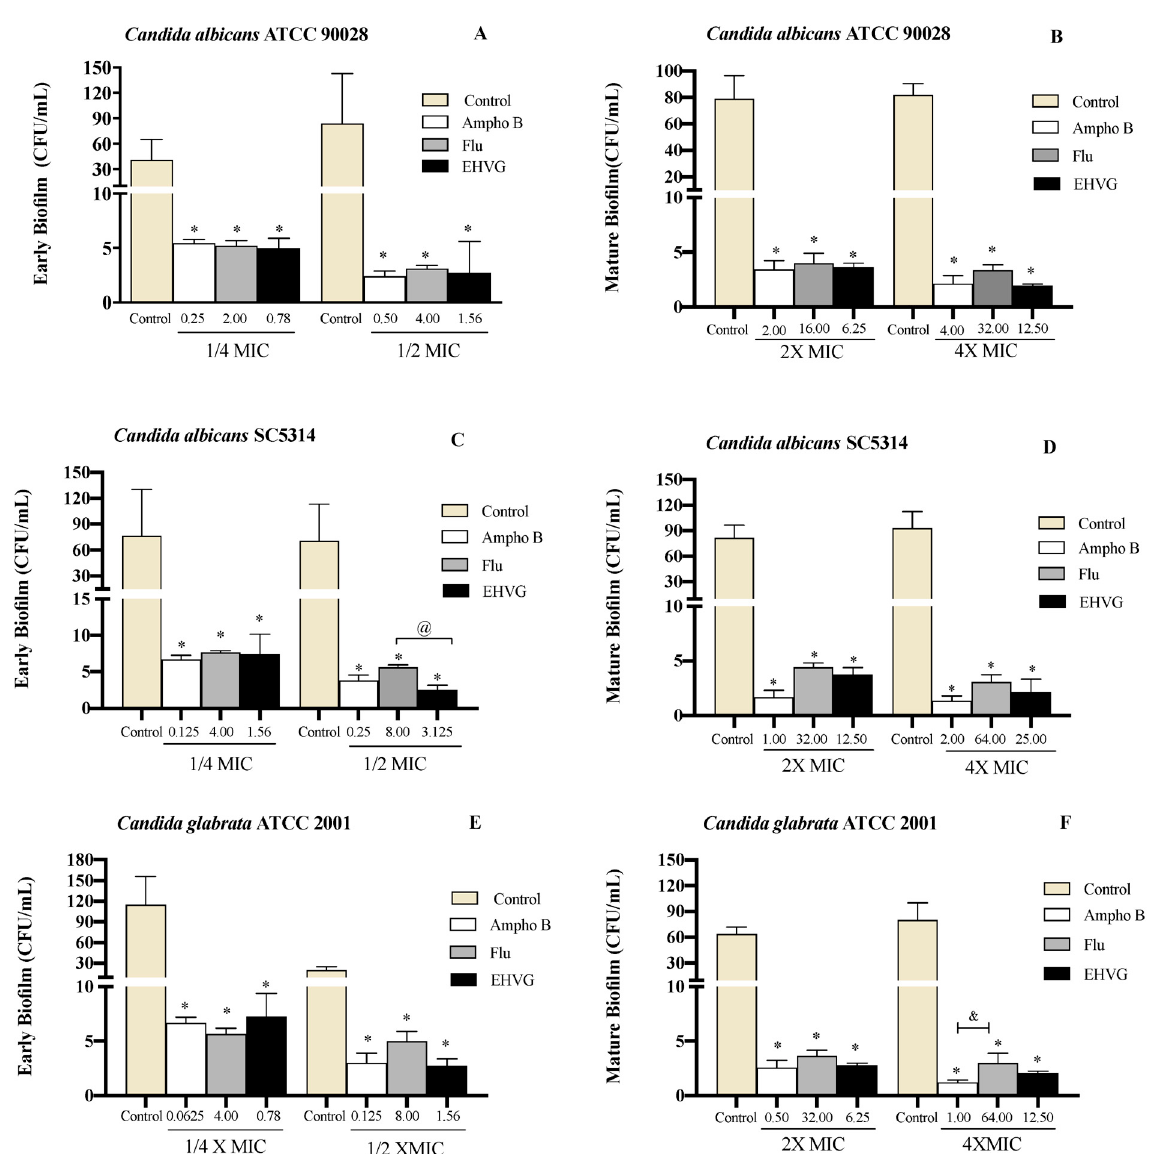
Figure 8. EHVG inhibited the formation of early ( A , C , E ) and mature ( B , D , F ) biofilms. The CFU/mL values were established in cultures of Candida albicans (ATCC 90028, A , B ; SC5314, C , D ) and C. glabrata (ATCC 2001, E , F ) after 48 h and 72 h. The samples treated with different concentrations of EHVG (1/4 and 1/2 × MIC for early biofilms, and 2 × and 4 × MIC for mature biofilms) were compared to cultures treated with Amphotericin B (Ampho B) or fluconazole (Flu), and with the untreated control. (*) p < 0.05 in comparison to control; (@) in comparison to Fluconazole, and (&) p < 0.05 Fluconazole compared to Amphotericin